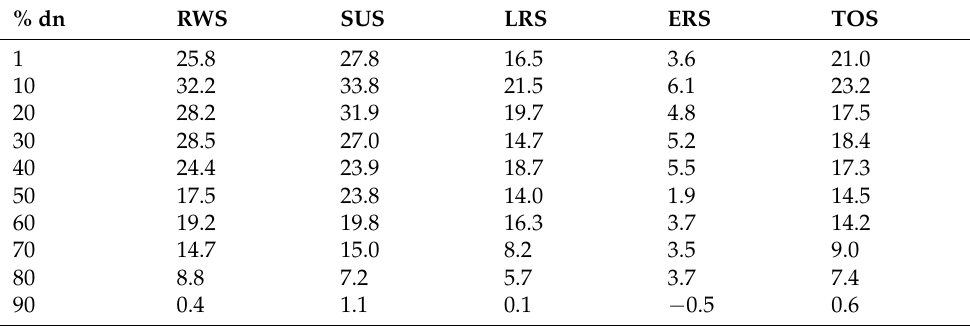
Table 5. Stability period Improvement of TRS over other selection